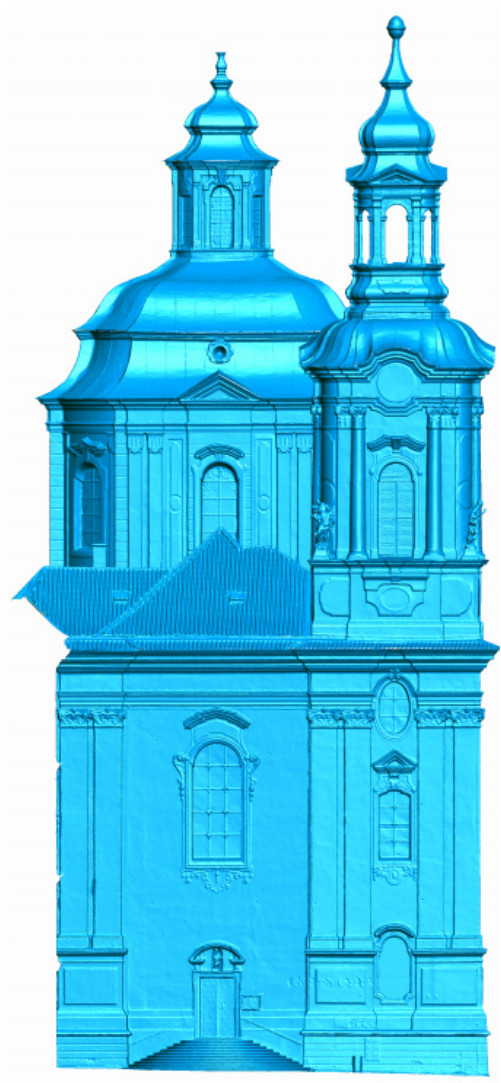
Figure 3. Church west façade mesh